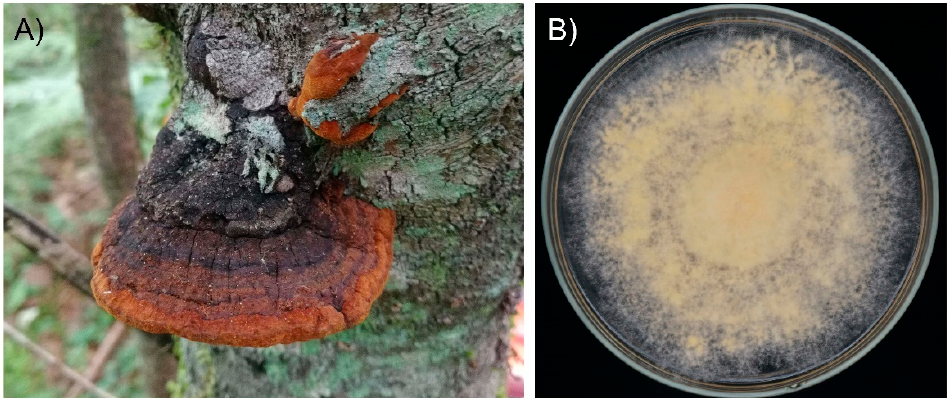
Figure 1. The fruiting body and colony of Sanghuangporus baumii . ( A ), The fruiting body of S. baumii . ( B ), Colony of S. baumii on chemically defined medium.